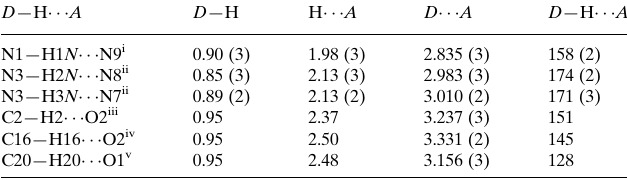
Data collection: CrystalClear (Molecular Structure Corporation & Rigaku, 2005); cell refinement: CrystalClear ; data reduction: Crys- talClear ; program(s) used to solve structure: SHELXS97 (Sheldrick, 2008); program(s) used to refine structure: SHELXL97 (Sheldrick, 2008); molecular graphics: ORTEP-3 for Windows (Farrugia, 2012) and DIAMOND (Brandenburg, 2006); software used to